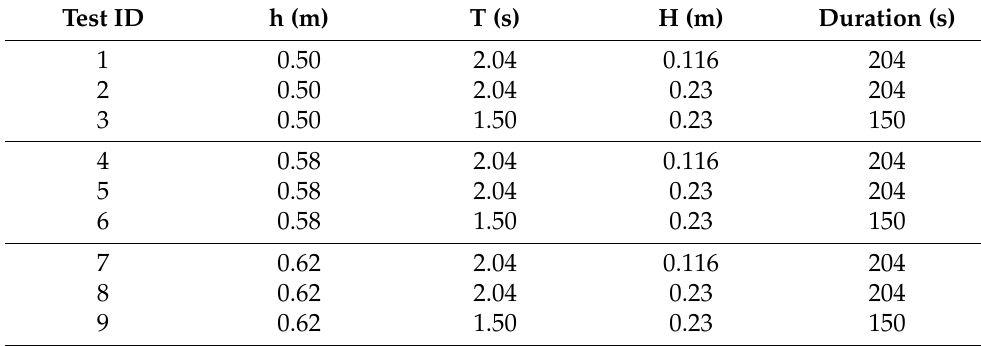
Table 1. Wave characteristics of the physical tests.